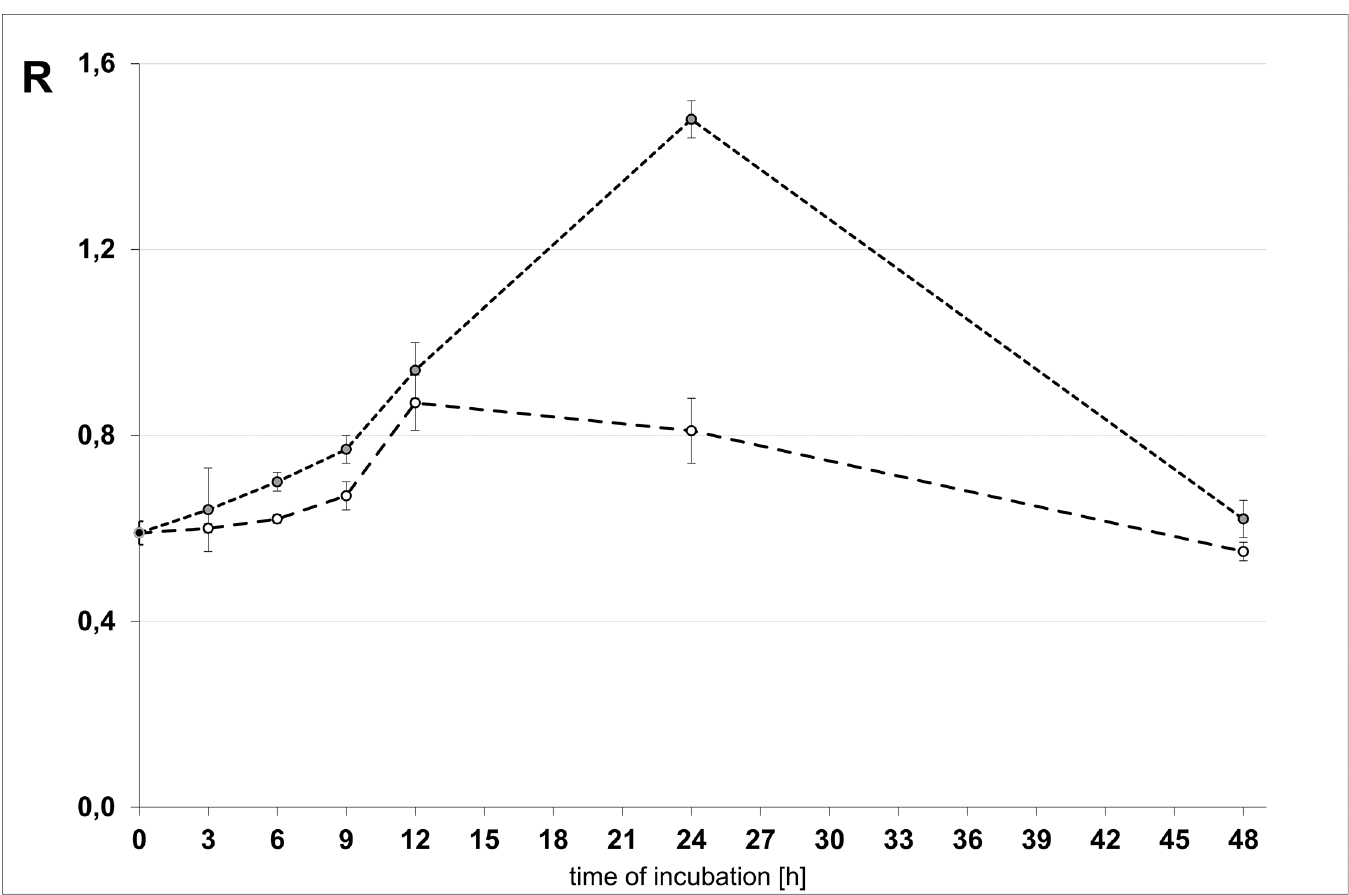
Fig 3. Time effect of TMZ on the DNA methylation status. U118 cell line treated with 250 μ M (empty circle) and 500 μ M (gray circle) of TMZ at 3, 6, 9, 12, 24 and 48 h. DNA not treated with temozolomide was used as a control (black circle). The contents of m 5 C is indicated on the Y axis. The highest content of m 5 C in DNA was observed after incubation of the cells 24 h with 500 μ M of